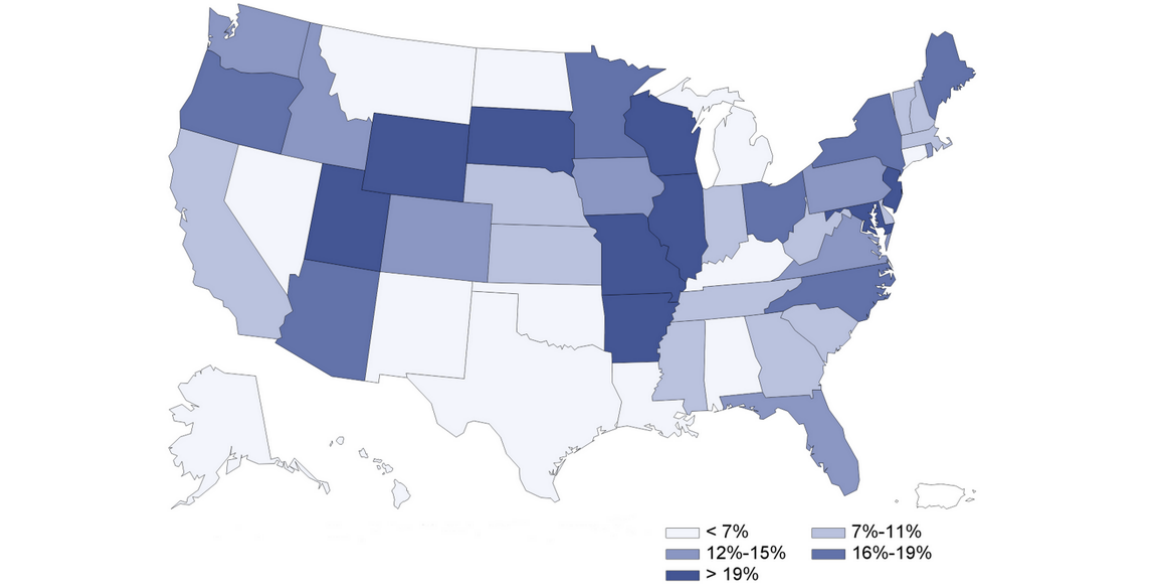
Figure 4. Proportion of hospitals having telemedicine intensive care unit capability by US state. RSV: relative search volume; ICU: intensive care